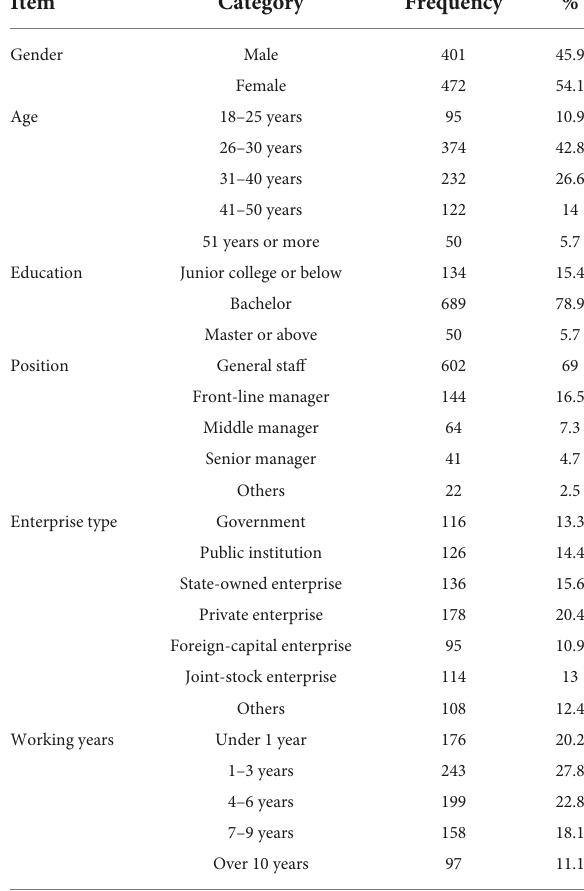
TABLE 1 Participants’ demographic